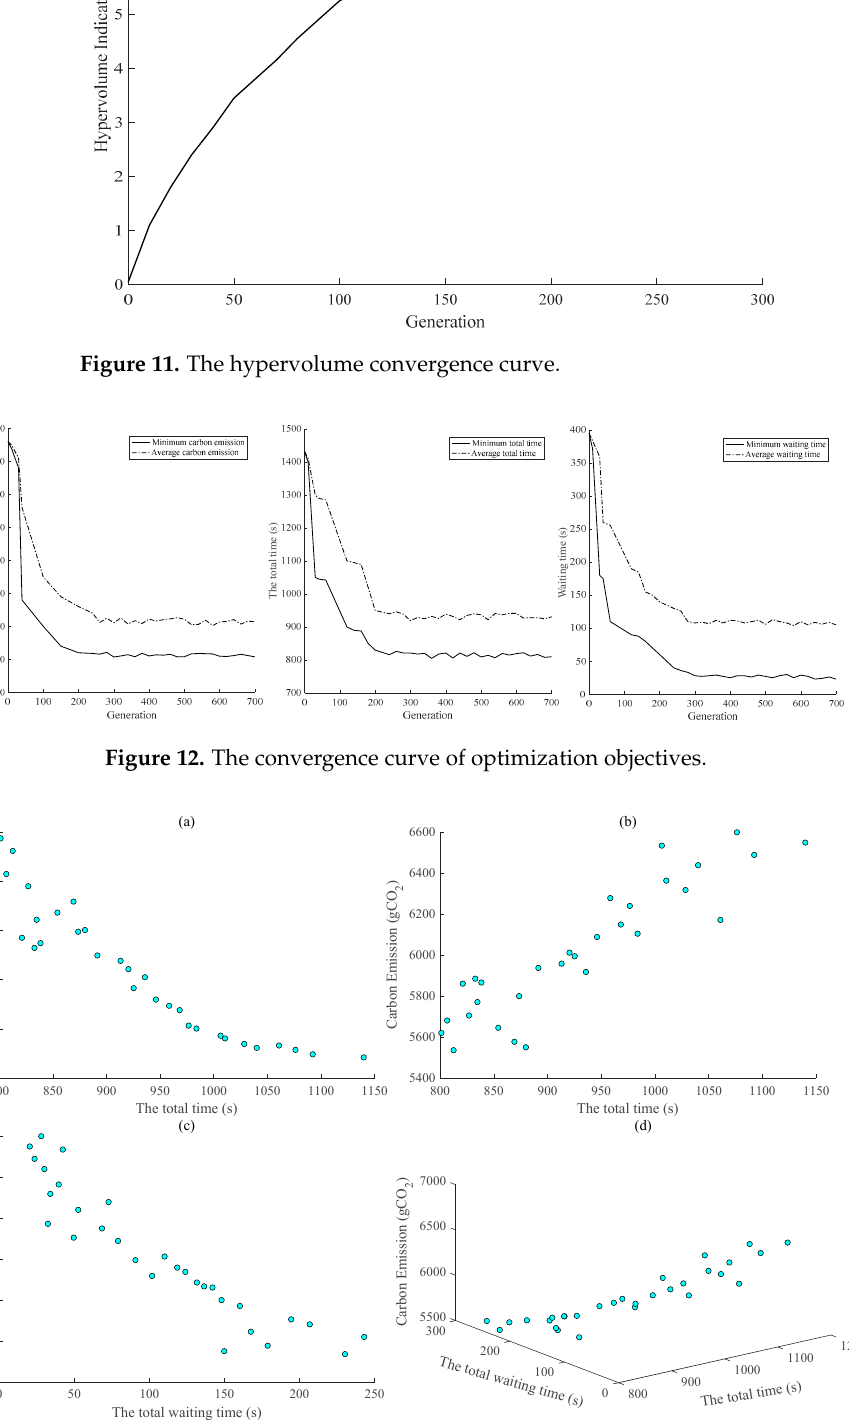
Figure 13. Non-dominated solution results.(( a ) the dependency between the total waiting time and the total time; ( b ) the dependency between the carbon emission and the total time; ( c ) the dependency between the total waiting time and the total waiting time; ( d ) the final Pareto optimal frontier.)